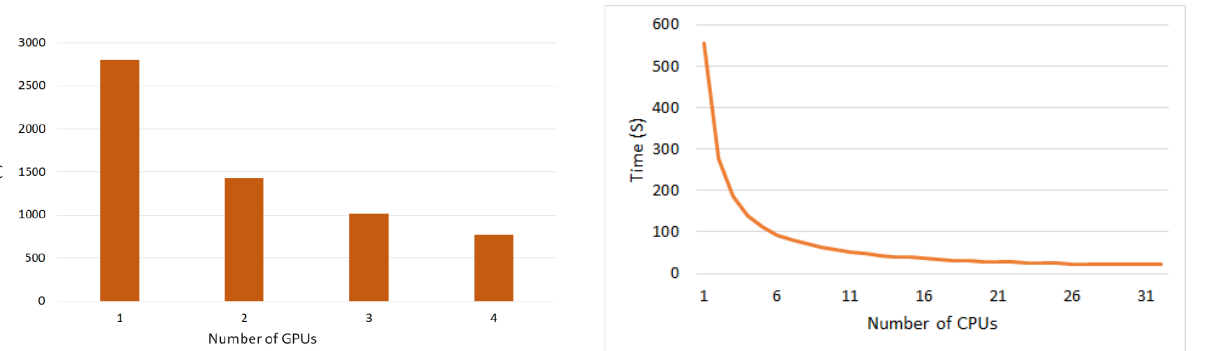
Figure 10. Comparison of time taken for multiple GPUs to process 1600-million-pixel images in a single HPC node.